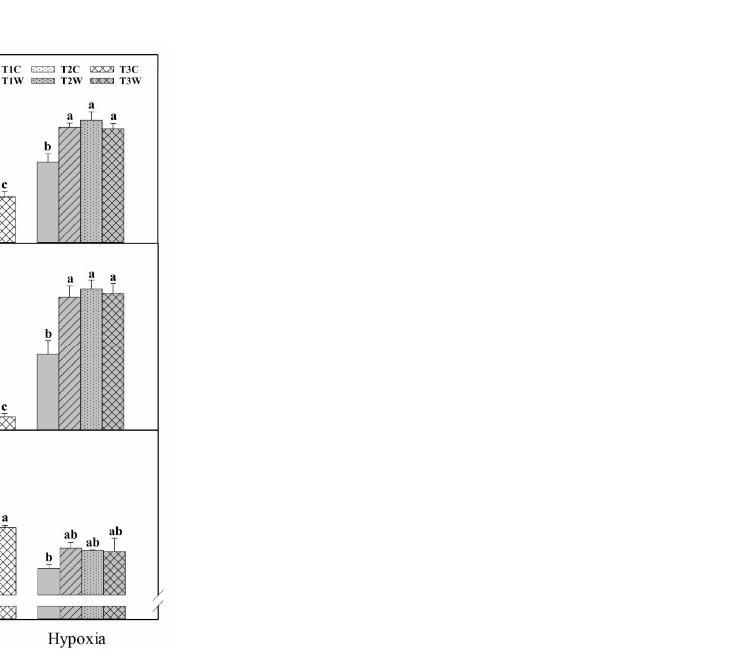
Figure 5. Effects of waterlogging priming on pyruvate decarboxylase activity, alcohol dehydrogenase activity and ATP content in root of offspring plants under hypoxia stress in wheat. Note: PDC: pyruvate decarboxylase; ADH: alcohol dehydrogenase; ATP: adenosine triphosphate. T0C, no priming + no offspring hypoxia stress; T0W, no priming + offspring hypoxia stress; T1C, one-generation priming + no offspring hypoxia stress; T1W, one-generation priming + offspring hypoxia stress; T2C, two-generation priming + no offspring hypoxia stress; T2W, two-generation priming + offspring hypoxia stress; T3C, three-generation priming + no offspring hypoxia stress; T3W, three-generation priming + offspring hypoxia stress. Data are means ± SE (n = 3). Different lowercase letters indicate the significant difference at p < 0.05 level.